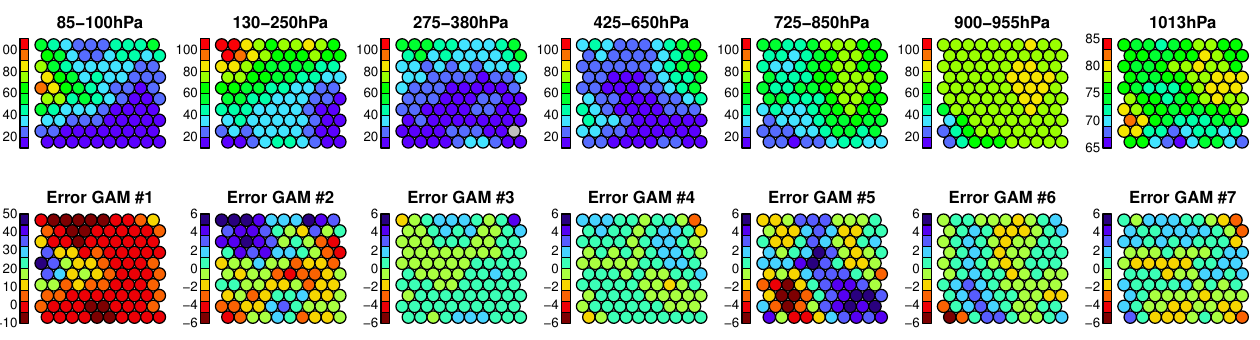
Figure 5. RH and the associated errors (both in %RH) projected on the 10 × 10-neuron self-organizing maps obtained from the step of clustering of the original RH profiles (see Sect. 2.1): the upper row shows the mean RH for the seven layers, and the lower row shows the errors of estimation using GAMs. Note that the color scales of the maps representing the 1013hPa layer and the error estimated for layer 1 are